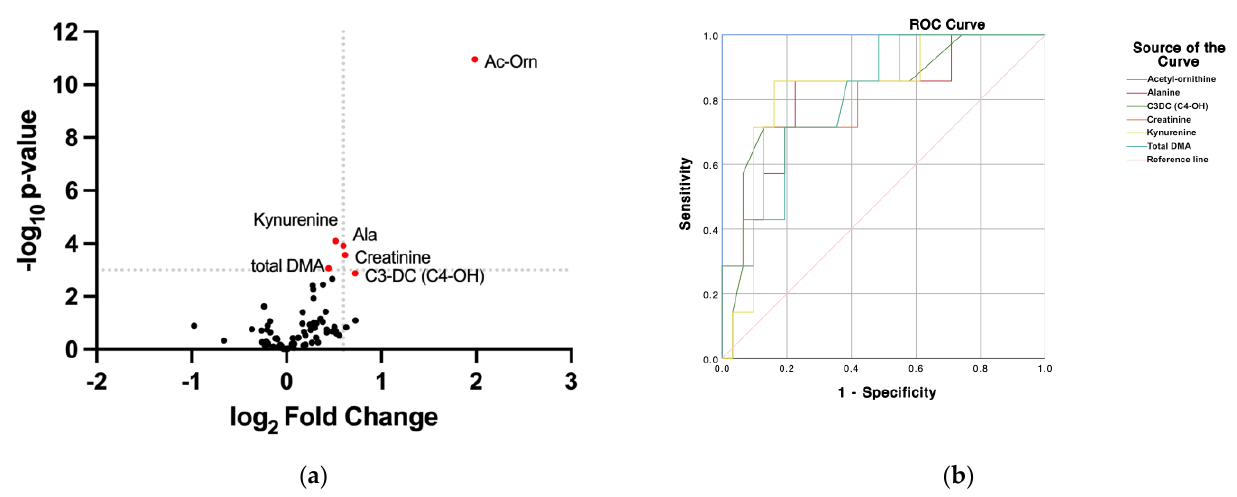
Figure 1. ( a ) Volcano plot (statistical significance versus log 2 fold change) upon comparing data from control and diabetes groups. Red color indicates data points for molecules whose log 2 FC > |0.4| and p < 0.001. ( b ) ROC curve of the six selected molecules.